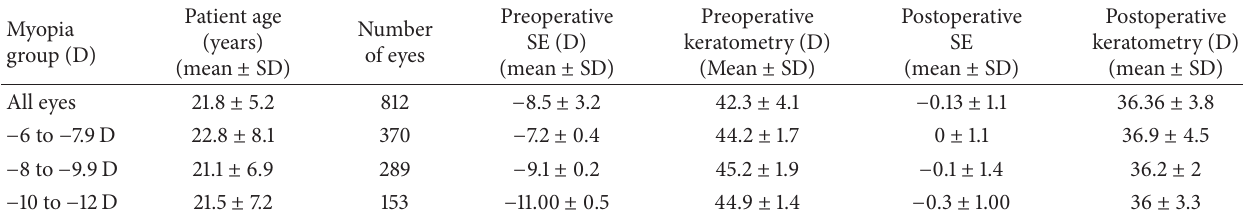
Table 1: Demographics of all eyes and the three groups stratified by degree of myopia.